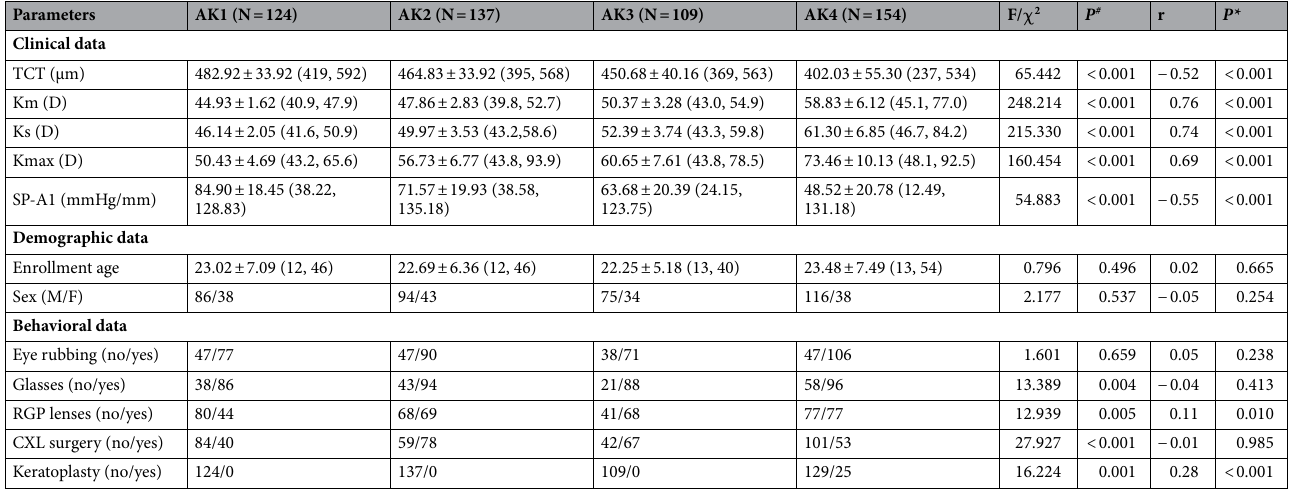
Table 3. The clinical, demographic, and behavioral data according to AK classification. TCT thinnest corneal thickness, Km mean keratometry, Ks steep keratometry, Kmax the maximum keratometry, SP-A1 stiffness parameter at the first applanation, RGP rigid gas permeable, CXL cross-linking. P # : the statistical value of the